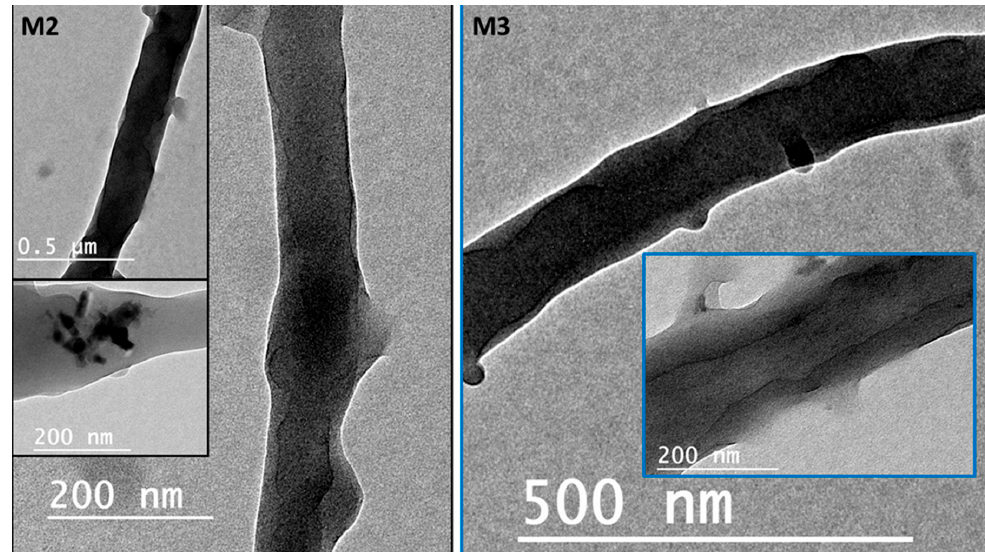
Figure 4. Transmission electron microscopy (TEM) images show the coaxial membranes morphology at different magnifications.